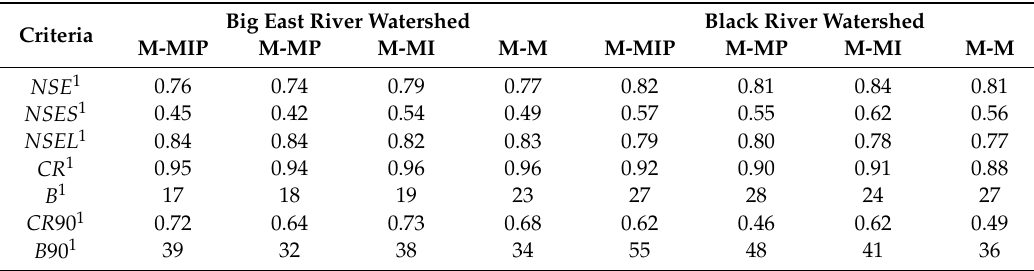
1 NSE : Nash Sutcli ff e e ffi ciency; NSES : NSE based on squared transformed streamflow; NSEL : NSE based on logarithmic transformed streamflow; CR : containing ratio; B : average bandwidth; CR 90: containing ratio based on stream flows more than 90 percentile; B 90: average bandwidth based on stream flows more than 90